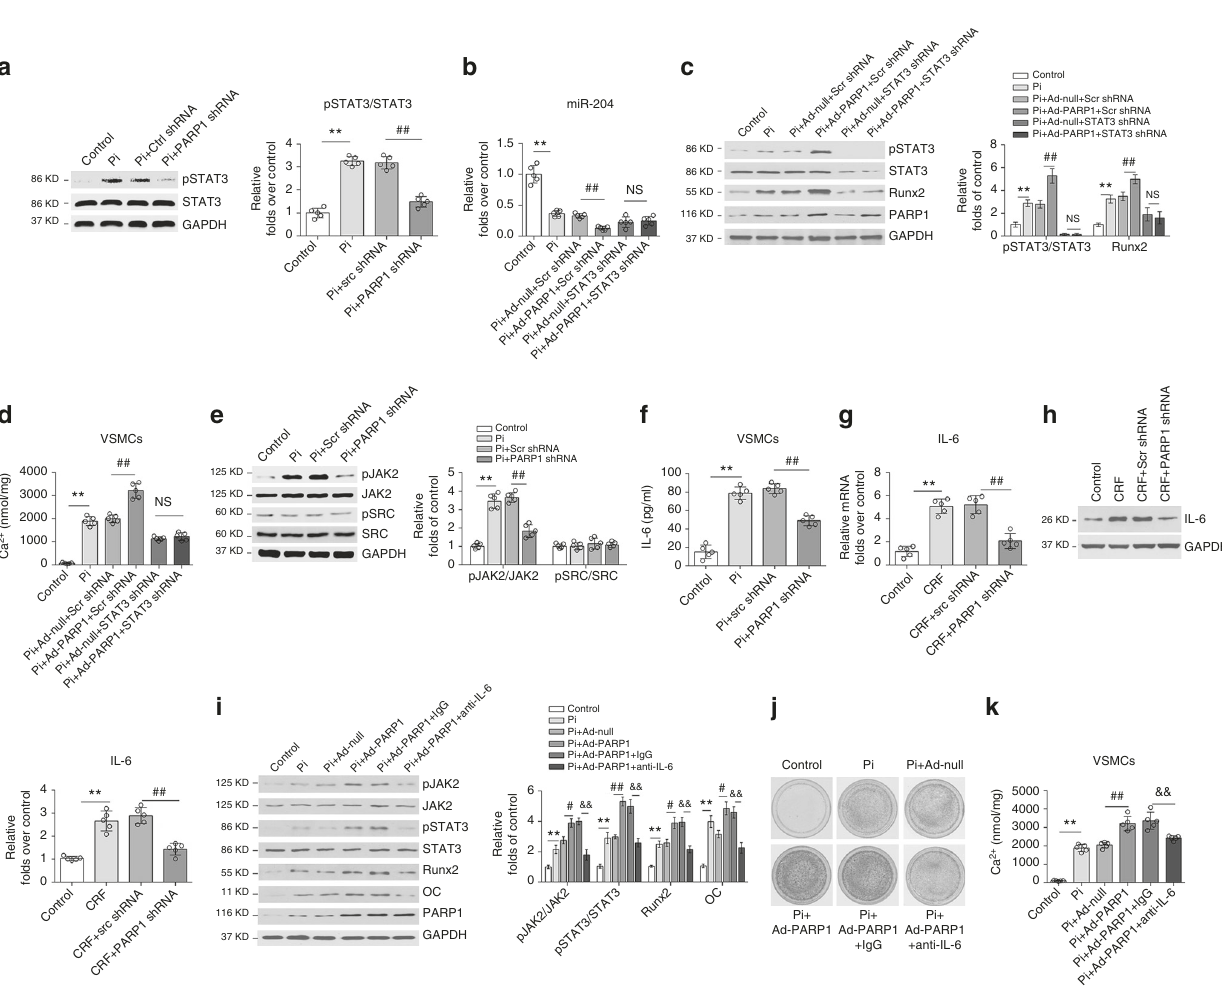
Fig. 6 PARP1 regulates miR-204 expression through the IL-6/JAK2/STAT3 pathway. a Rat VSMCs was pre-infected with Scr shRNA or PARP1 shRNA, and then exposed to high Pi for 3 days. The phosphorylation of STAT3 (pSTAT3) and STAT3 were determined by western blot. ( n = 5 per group). b – d , VSMCs were infected with Scr shRNA or STAT3 shRNA, along with Ad-Null or Ad-PARP1, and then incubated with osteogenic media for 14 days. MiR-204 expression was determined by qRT-PCR ( b ). The expression of pSTAT3/STAT3 and Runx2 was analyzed by western blot ( c ), and the calcium deposition was quanti fi ed by the calcium assay ( d ). ( n = 5 per group). e The phosphorylation of JAK2 and SRC, and their total proteins in calci fi ed VSMCs infected with Scr shRNA or PARP1 shRNA were determined by western blot. f The level of IL-6 in the supernatant of calci fi ed VSMCs was detected by ELISA assay. g , h The mRNA ( g ) and protein ( h ) levels of IL-6 in the abdominal arteries of CRF rats inoculated with Scr shRNA or PARP1 shRNA were determined by qRT-PCR and western blot. ( n = 5 per group). i – k Rat VSMCs were pre-infected with Ad-Null or Ad-PARP1, and then treated with neutralizing antibodies against IL-6 in the osteogenic media for 14 days. The levels of pJAK2/JAK2, pSTAT3/STAT3 and osteogenic markers (OC and Runx2) were determined by western blot ( i ), and the calci fi cation was detected by Alizarin red S staining ( j ) and calcium quanti fi cation ( k ). ( n = 5 per group). Statistical signi fi cance was assessed using one-way ANOVA followed by for multiple comparison and is presented as follows: NS: no signi fi cance, ** P < 0.01, # P < 0.05, ## P < 0.01, & P < 0.05 and && P < 0.01. All values are means ± S.D. Source data are provided as a Source Data fi